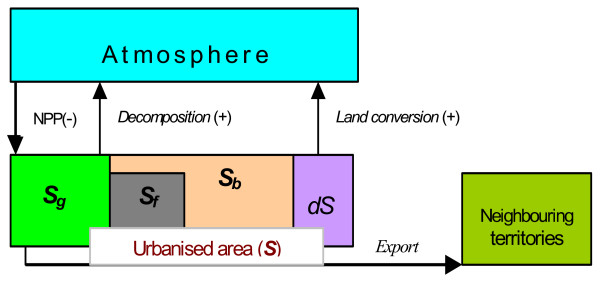
Carbon flows in an "urbanised" ecosystem. Flows:1. Production „NPP” = (NPP)* Sg, 2. „Decomposition”= =(1 - ke)(NPP)* Sg, 3. "Land conversion", dCl = (B* + D*)dS, 4. "Export" = ke(NPP)* Sg. The (NPP)*, B* and D* are the local stationary values of the NPP, living biomass and humus, correspondingly; the coefficient ke is a fraction of dead organic matter exported from the "urban" ecosystem into neighbouring territories. Areas:1. Sg – „Green” area (park zone), 2. Sf – area occupied by favelas, 3. Sb – built-up area, 4. dS – annual increment of urbanised area, S = Sg + Sf + Sb – total urbanised area.